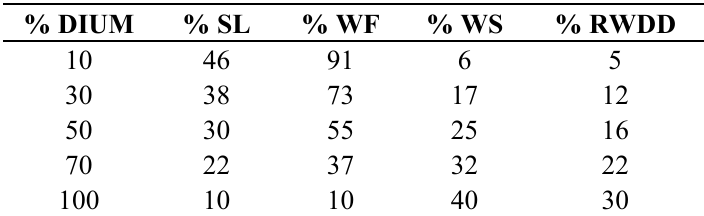
Table 5. Summary of five DIUM